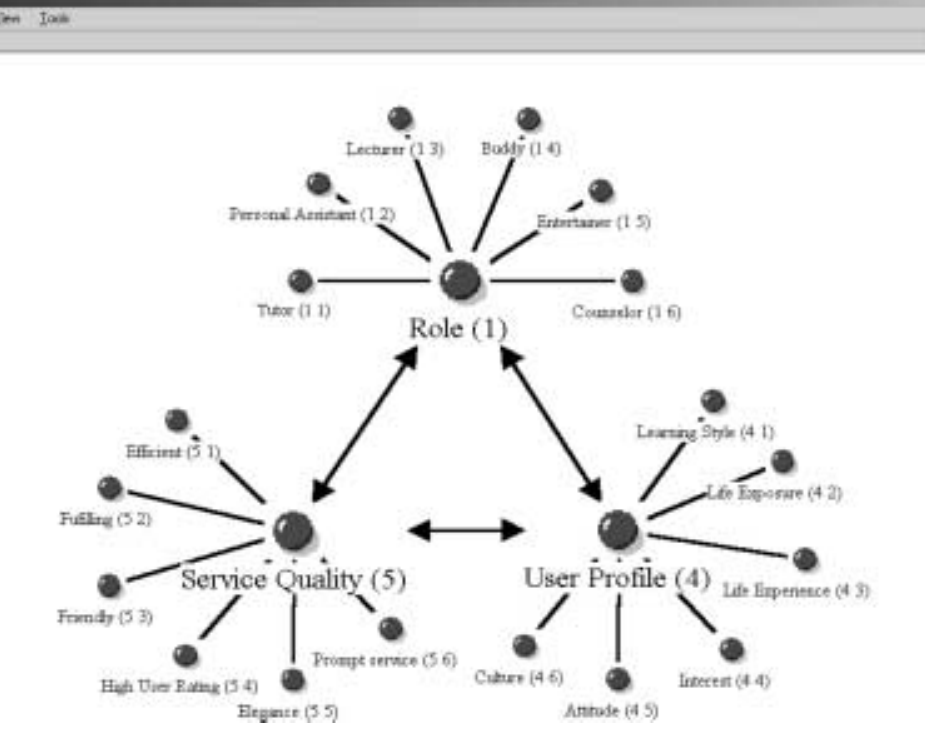
Figure 1. Animated agent design